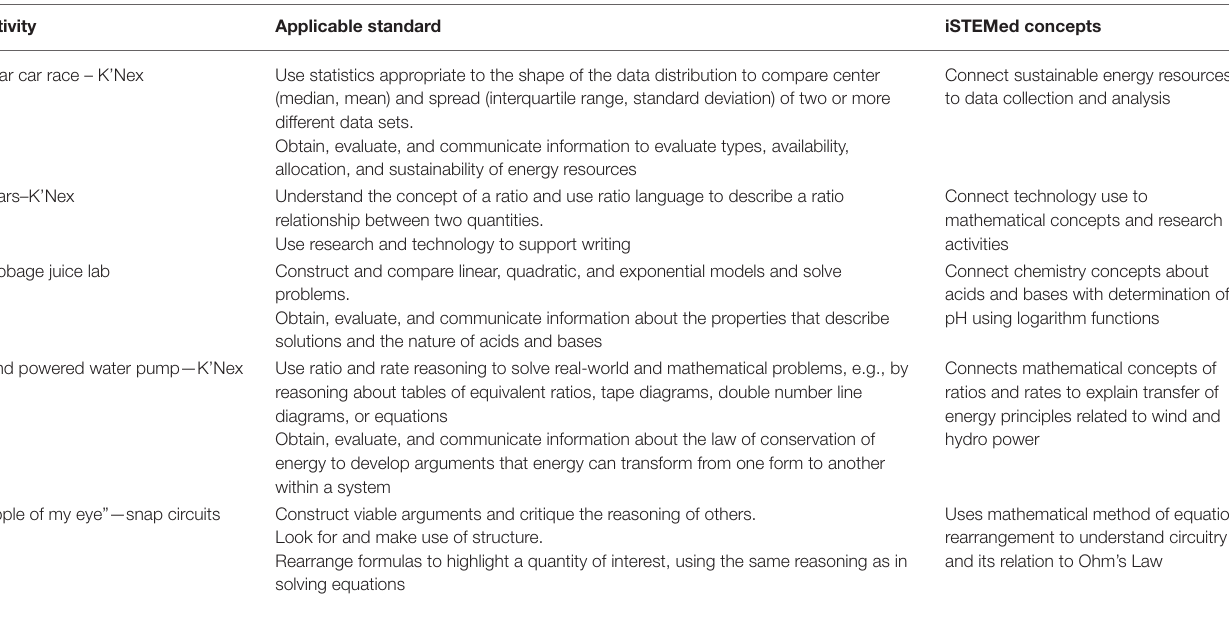
TABLE 1 | Alignment of PD activities with CCSS and state standards, and iSTEMed